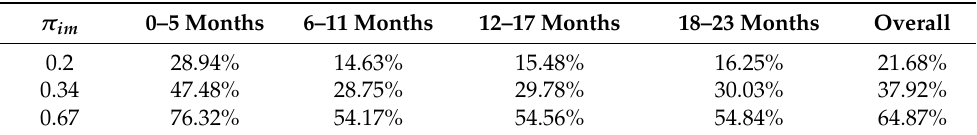
Figure 5. Bronchiolitis counts (black line) together with simulated counts (mean values) for three different immunization proportions: π im = 0.2 (green line), 0.34 (blue line) and 0.67 (red line). Table 2. Expected decrease in the number of bronchiolitis counts for three different immunization proportions: π im = 0.2, 0.34 and